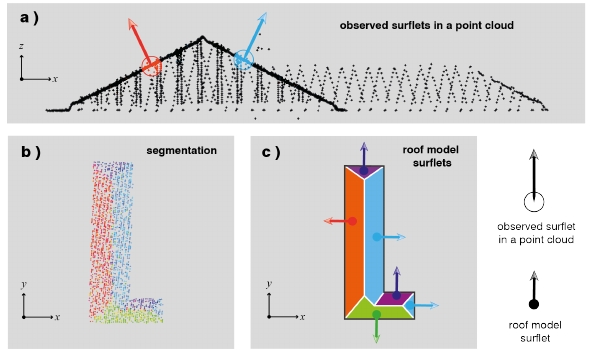
Figure 2. a) A surflet pair/model hypothesis (green, blue) derived by filtering, front view of the point cloud. b) corresponding roof model surflets